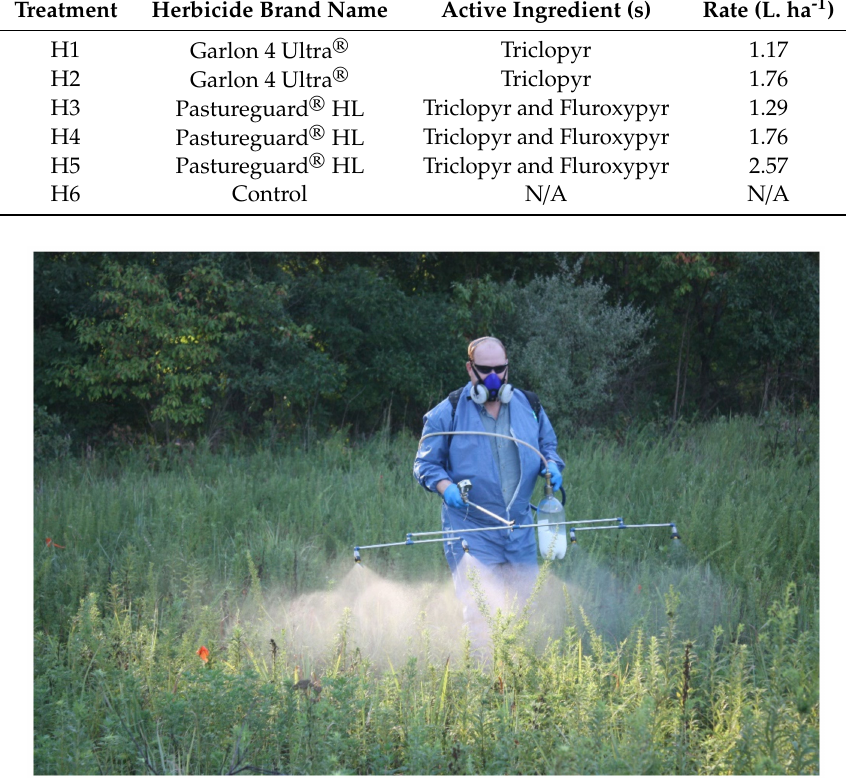
Figure 3. Applying triclopyr and fluroxypyr herbicide to experimental plots dominated by Lespedeza cuneata . Photo © David